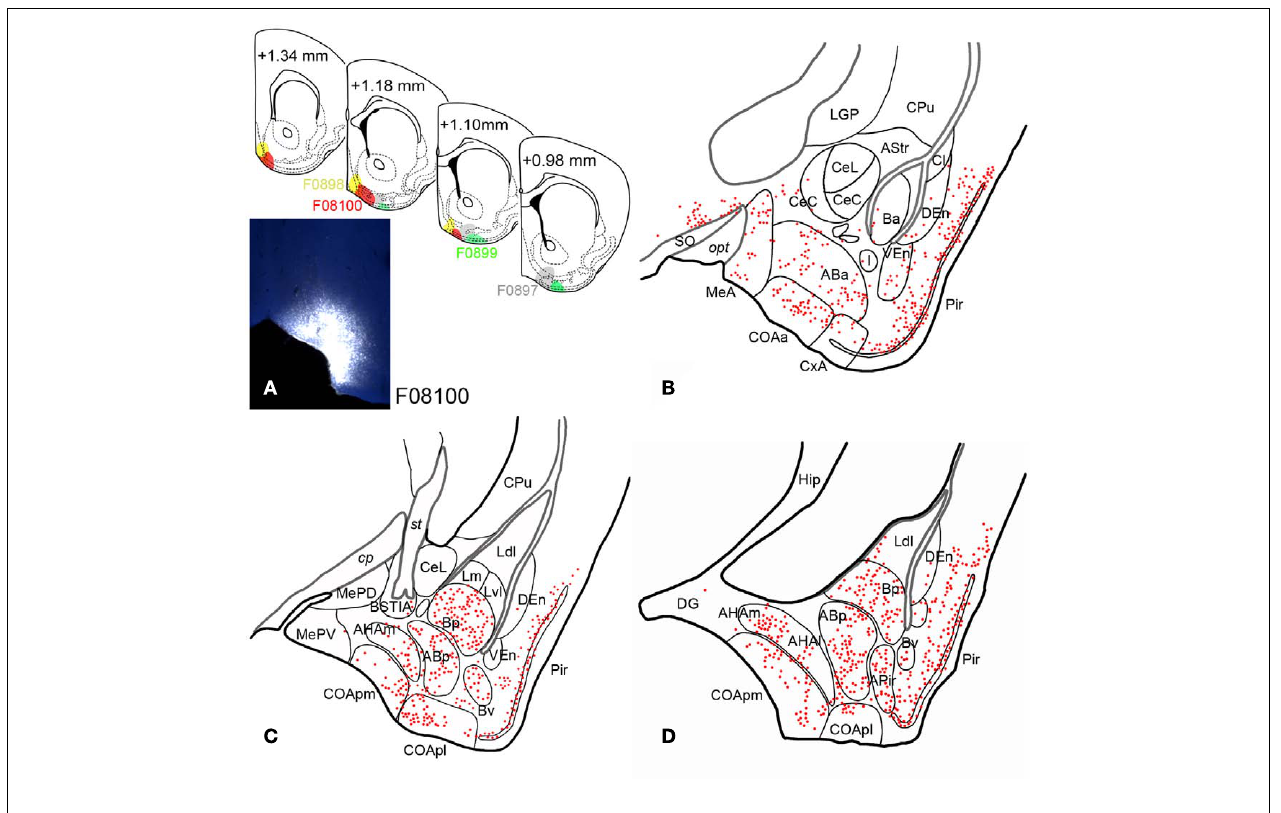
mapped in (B–D) . (B–D) Camera lucida drawings of frontal sections of the amygdala of a mouse mapping the retrograde labeling observed after an injection of fluorogold in the ventromedial olfactory tubercle (F08100). Note that retrogradely labeled neurons appear both in olfactory and vomeronasal nuclei and also in non-chemosensory amygdaloid structures, such as the basolateral amygdaloid